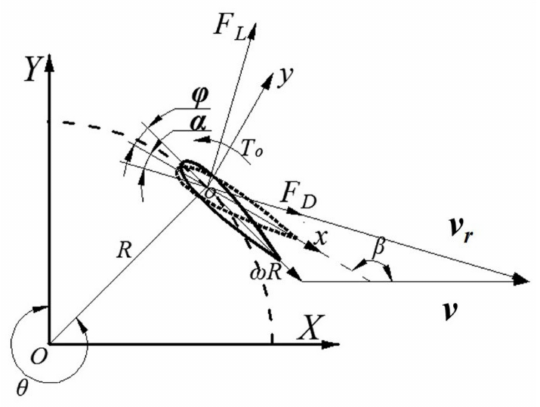
Figure 4. Blade force on H-Darrius